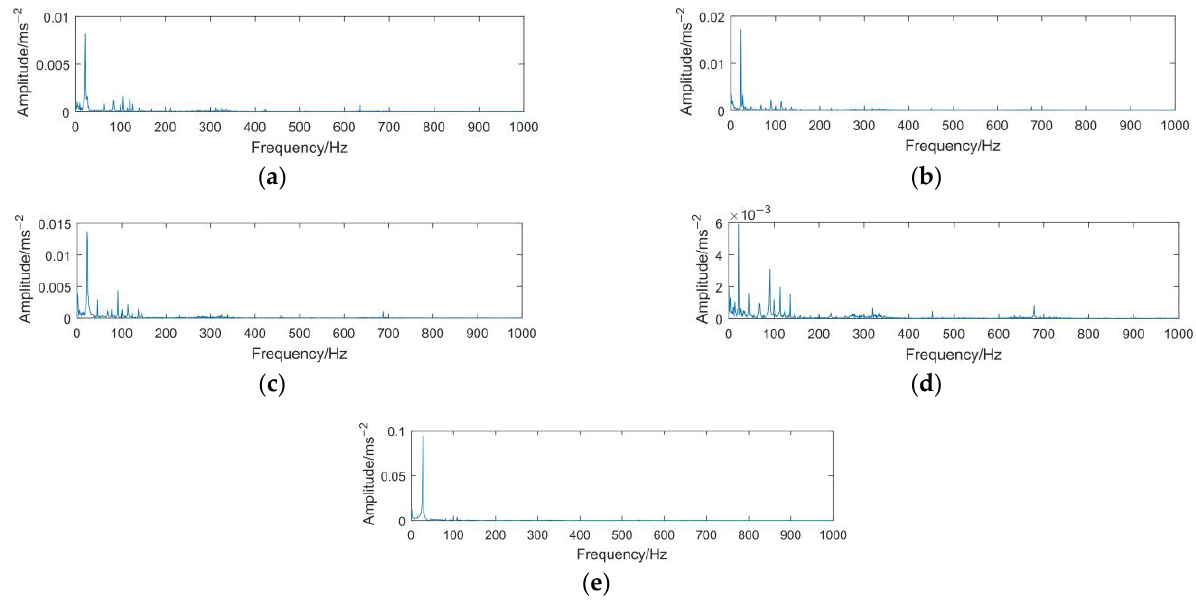
Figure 7. The spectrum of a group of rotor signals: ( a ) Nor, ( b ) BBLF, ( c ) MF, ( d ) IF, ( e ) LRIF. The center frequency of each IMF component of an MF signal obtained by VMD un- der different K values is shown in Table 5. Table 5. The center frequency of each IMF component corresponds to different K values.